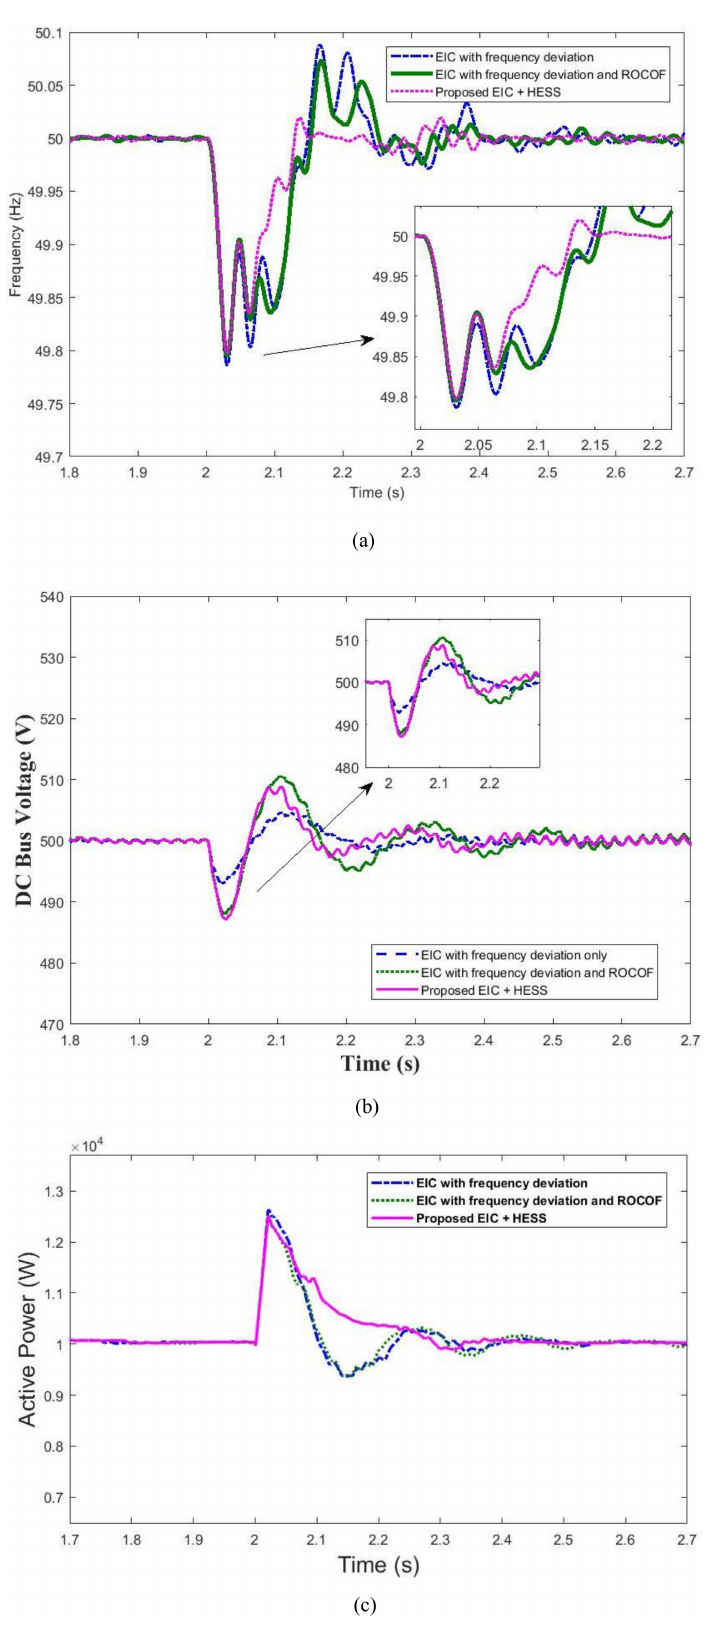
Figure 13. Performance verification with different EIC strategies; ( a ) frequency, ( b ) DC bus voltage, ( c ) Active power injected from grid-connected PV